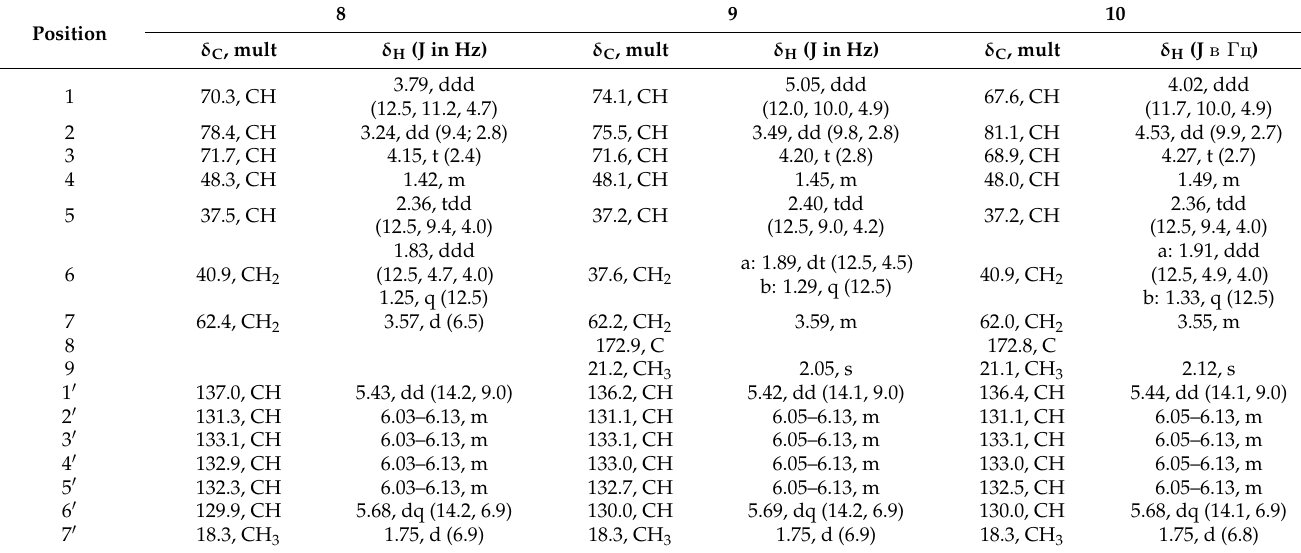
Table 2. NMR data (600 MHz, methanol-d 4 , δ in ppm) for compounds 8–10 .